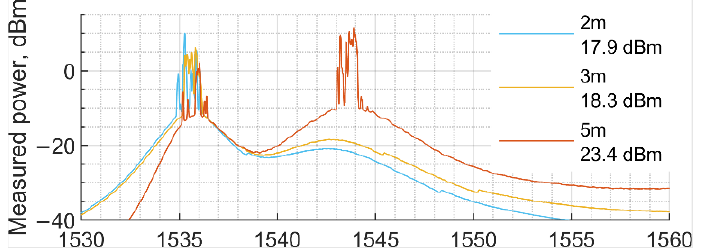
Figure 7. Optical spectra measured for the EYDFA configuration with no input signal with a pump power of 2 W. Lasing is seen that is temporally unstable both in wavelength (within 1 nm) and peak power.